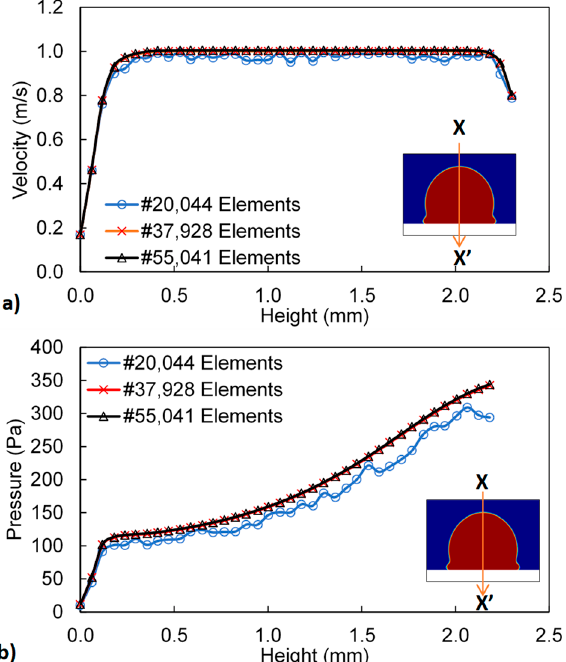
Figure 4. Grid independence solution along with vertical height (X ‐ X’) for: ( a ) velocity magnitude and ( b ) pressure variation (gage pressure) at 0.054 s. Droplet volume is 10 μ L droplet and impact height is 20 mm. Table 1. Fluid properties and micro-post array sizes were adopted in the